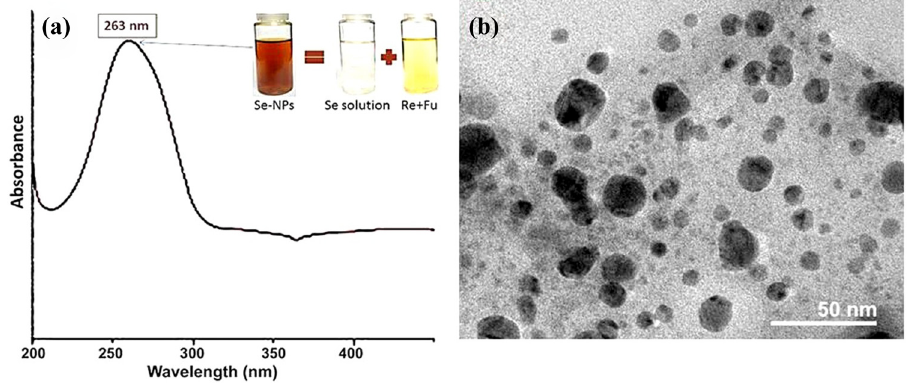
Figure 3: Structural attributes of Re – Fu - mediated SeNPs, including their UV - absorbance spectrum ( a ) and ultrastructure via TEM ima - ging ( b )